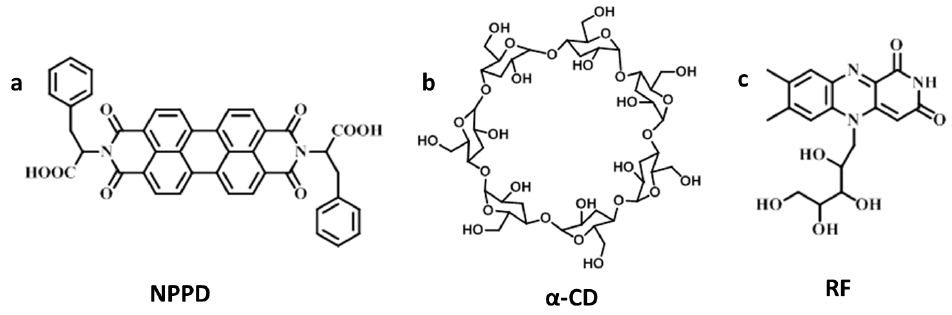
Figure 1. Chemical structures of N , N ′-diphenylalanine-3,4,9,10-tetracarboxylic diimide (NPPD); α-cyclodextrin (α-CD); riboflavin (RF).